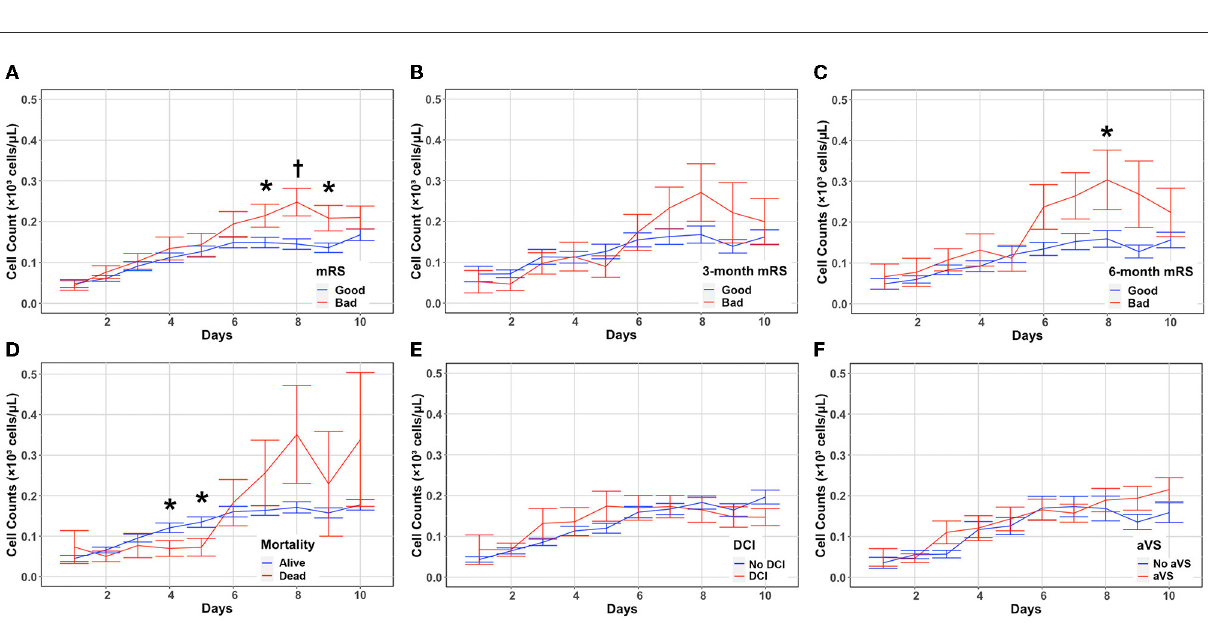
increase seen in those patients with higher clinical severity and GCE. Eosinophil counts later after injury, notably on the post- bleed day (PBD) 8, had an independent association with functional outcomes. PBD 8 eosinophil count also had moderate sensitivity and high specificity for predicting poor